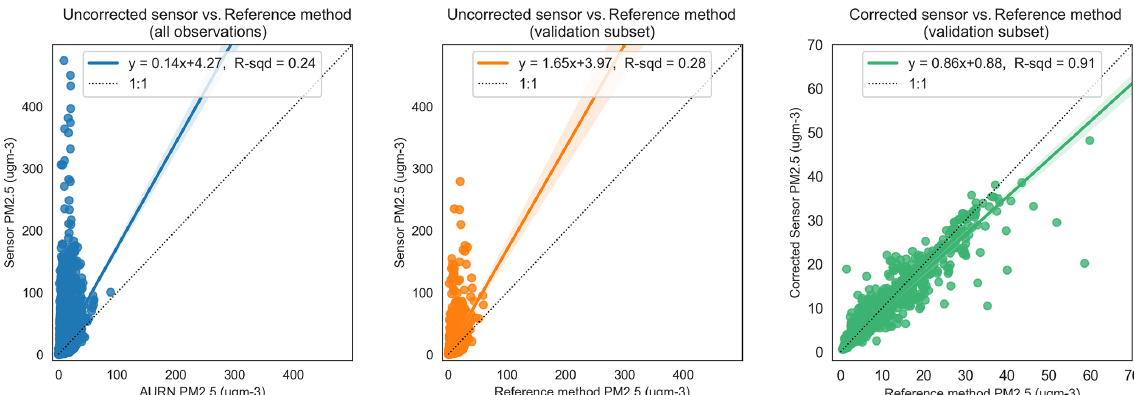
Figure 8. Relationship between uncorrected sensor, RF-model-corrected sensor and reference method observations for PM 2 . 5 . The dotted line shows the unity slope. R-sqd: R 2 . ugm-3: µgm − 3